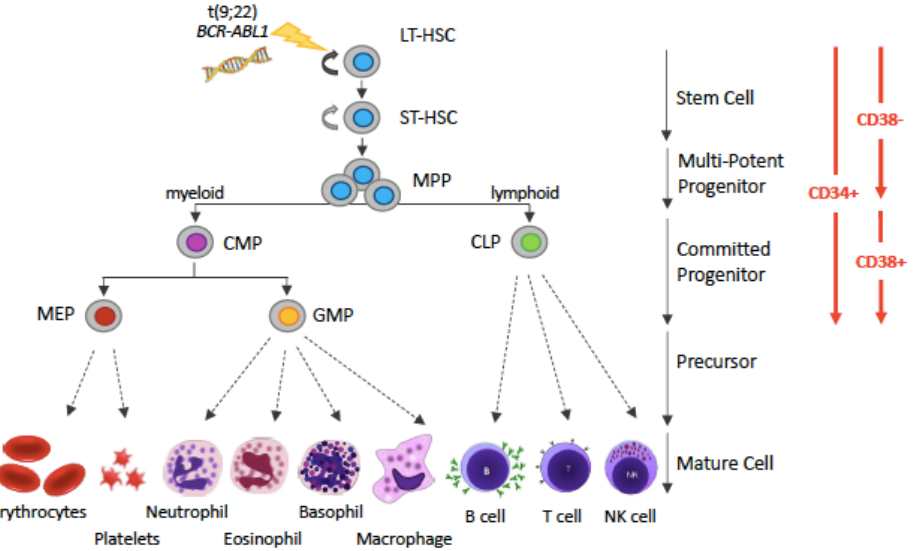
Figure 1. Simplified representation of the hematopoietic hierarchy. Hematopoiesis follows a hierarchical organization with hematopoietic stem cells (HSCs) on top and mature blood cells at the bottom. HSCs are the sources of various types of progenitor cells that proliferate extensively, forming more differentiated cells at the expense of their self-renewal capacity. The various types of precursor cells have been omitted, for simplicity (and this is denoted by dotted arrows instead of solid arrows). The driver lesion of CML, the t(9;22) chromosomal translocation giving rise to the BCR-ABL1 fusion gene, is gained at the HSC level. Abbreviations: LT-HSC: long-term hematopoietic stem cell; ST-HSC: short-term hematopoietic stem cell; MPP, multi-potent progenitor; CMP, common myeloid progenitor; CLP, common lymphoid progenitor; MEP, megakaryocyte-erythrocyte progenitor; GMP, granulocyte-monocyte progenitor.